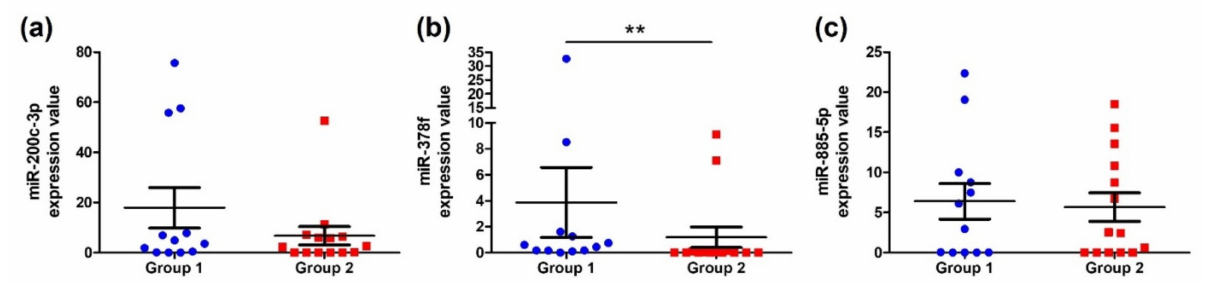
Figure 2. The expression levels of three DE miRNAs in groups 1 and 2: ( a ) miR-200c-3p, ( b ) miR-378f, ( c ) miR-885-5p. Group 1: received fewer than 4 cycles of XELOX chemotherapy. Group 2: received 4–7 cycles of XELOX chemotherapy. ** represents p < 0.01.